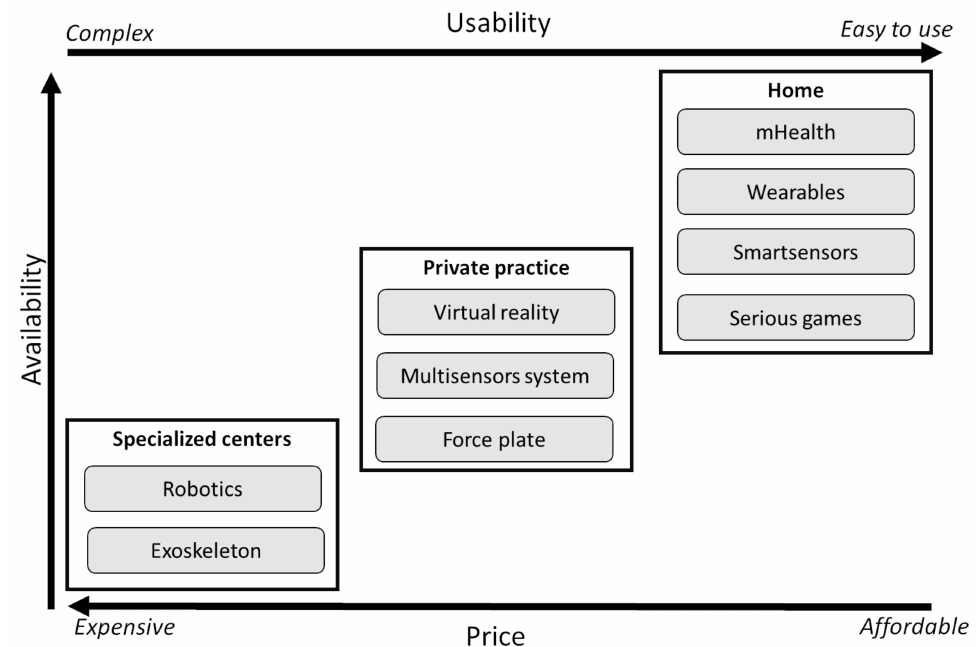
Figure 2. Schematic representation of technology-supported rehabilitation. Note that several tech- nologies can be used in different categories (namely specialized centers, private practice or at-home). The x-axis represents the price and ease of use of the technology. For example, robotics technology is expensive (>$100,000) and requires trained staff, while mHealth apps prices are usually between $1 and $50 per year and can be used by the patients themselves without help or support. On the y-axis is the availability of the devices for both patients and